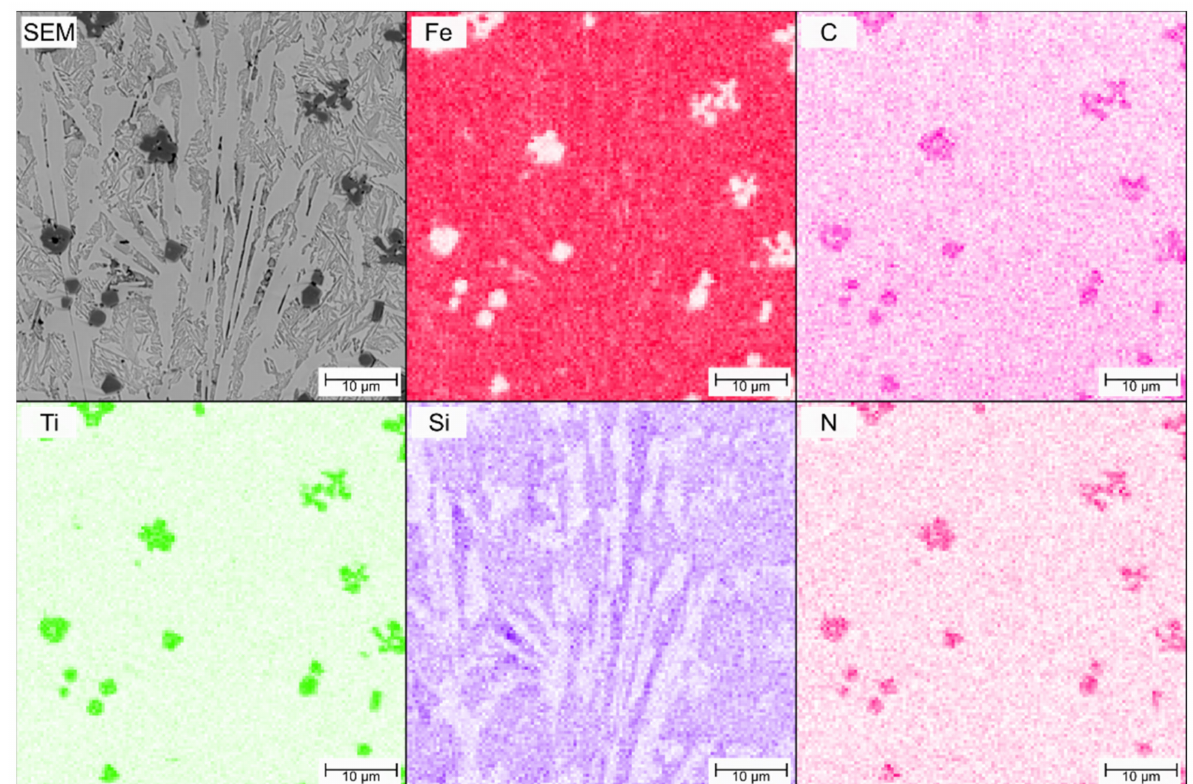
Figure 6. The EDS mapping of the composition of the representative laser-alloyed surface